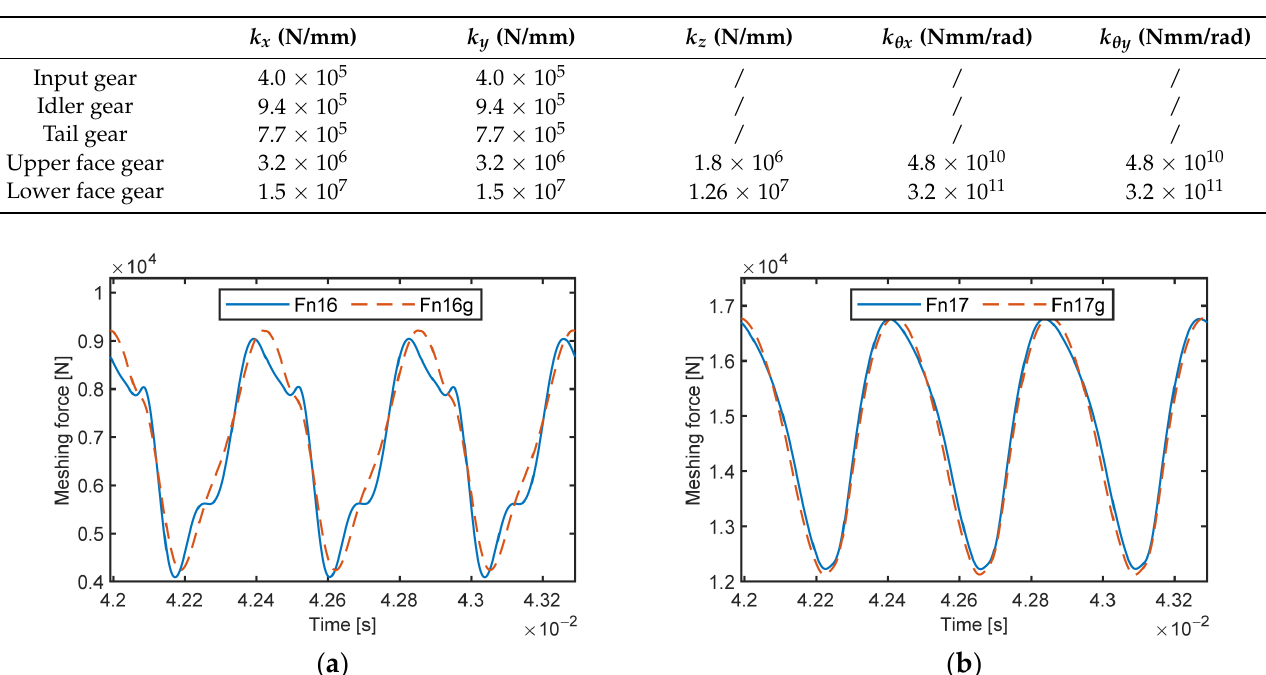
Table 2. Values of gear support stiffness.